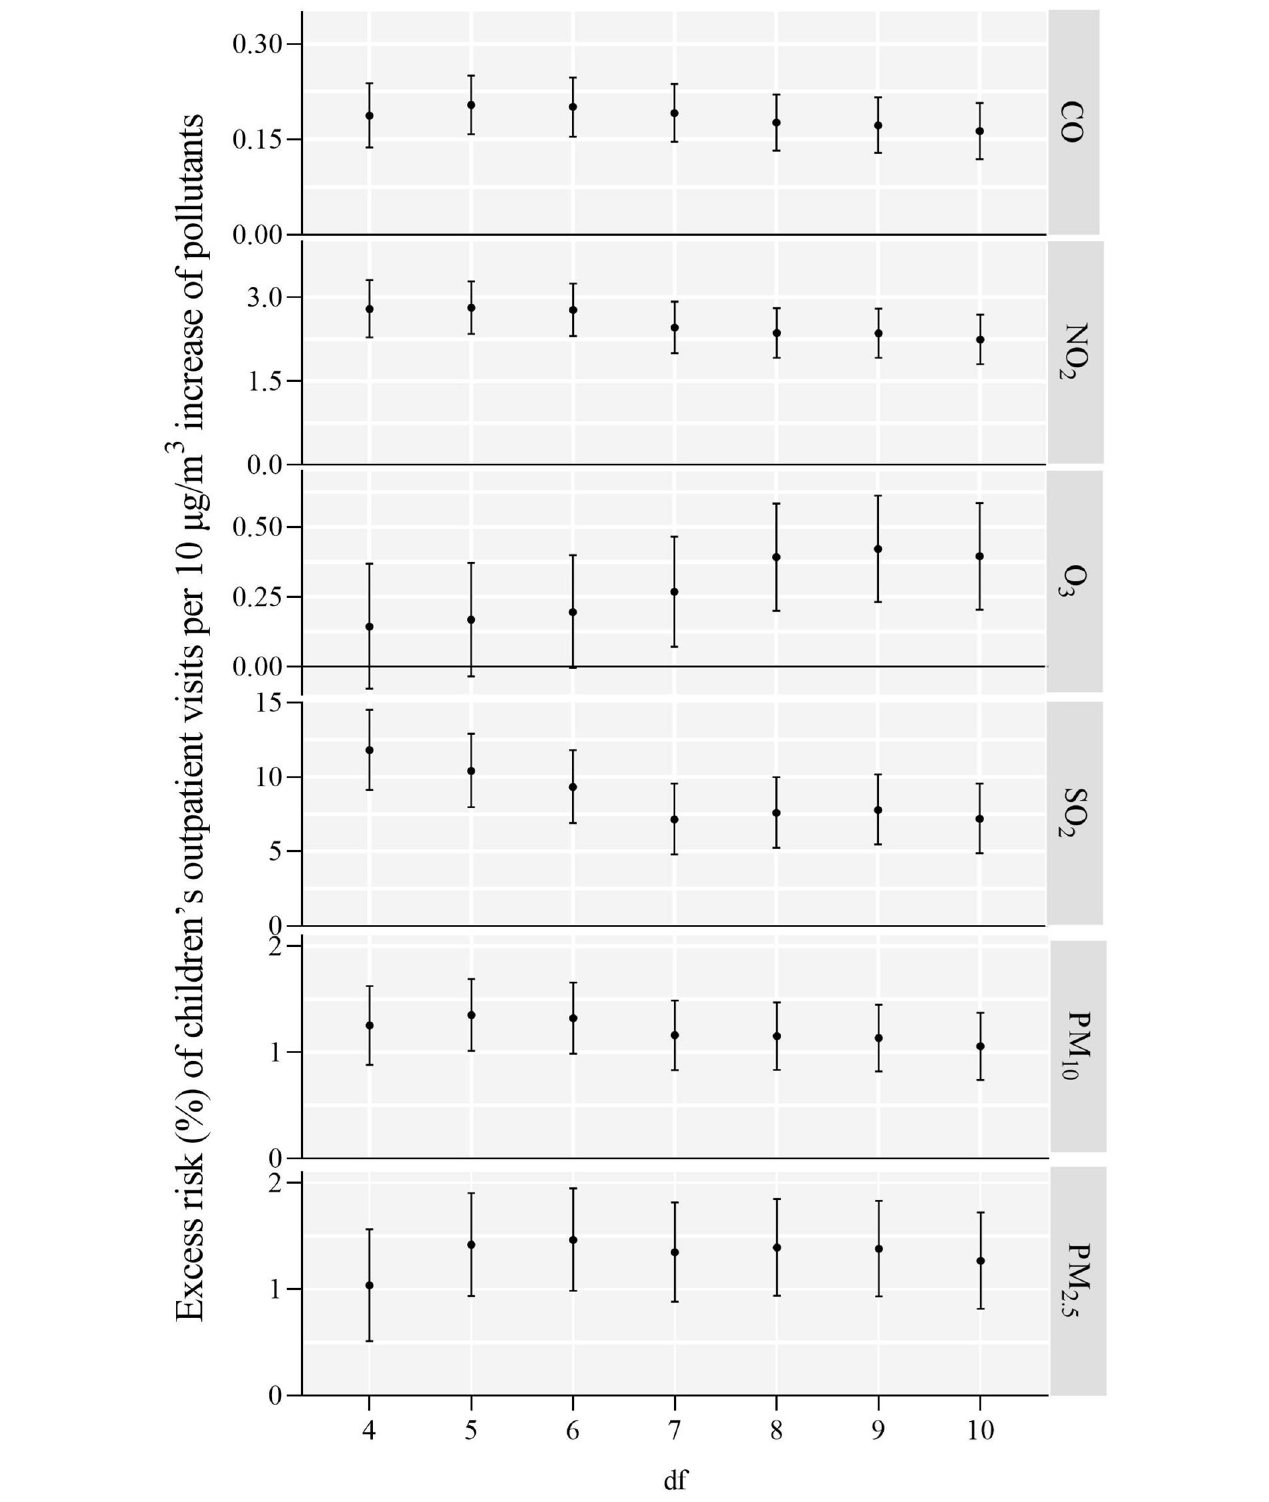
FIGURE3 ER (%) and 95% CI of children’s outpatient visits a 10 µ g/m 3 increase in air pollution concentrations on the day of exposure.